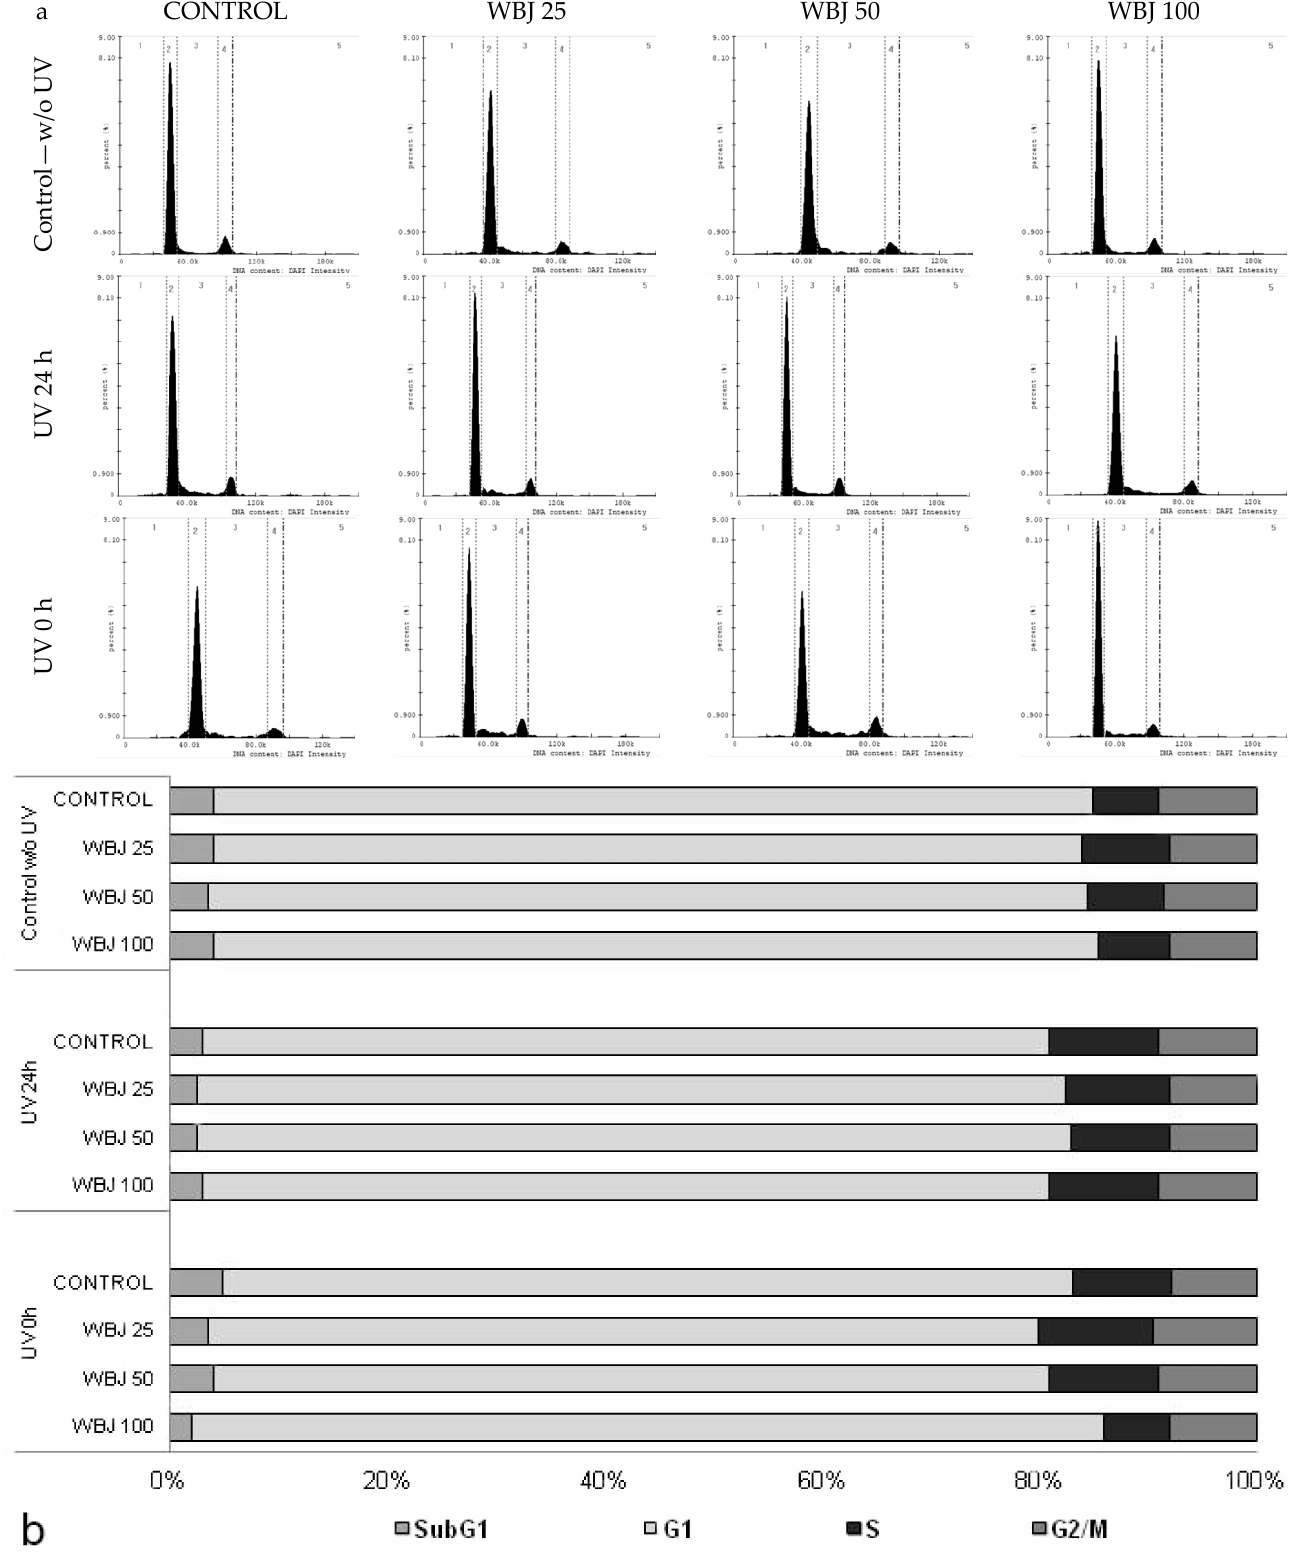
Figure 8. Analysis of cell cycle parameters in an NHSF cell line incubated for 48 h with water extract of young barley juice (WBJ) at concentrations of 25, 50 and 100 µ g/mL. Histograms ( a ) illustrate the amount of DNA based on fluorescence intensity measurements. Graph ( b ) shows the percentage distribution of cells in each phase of the cycle compared to the